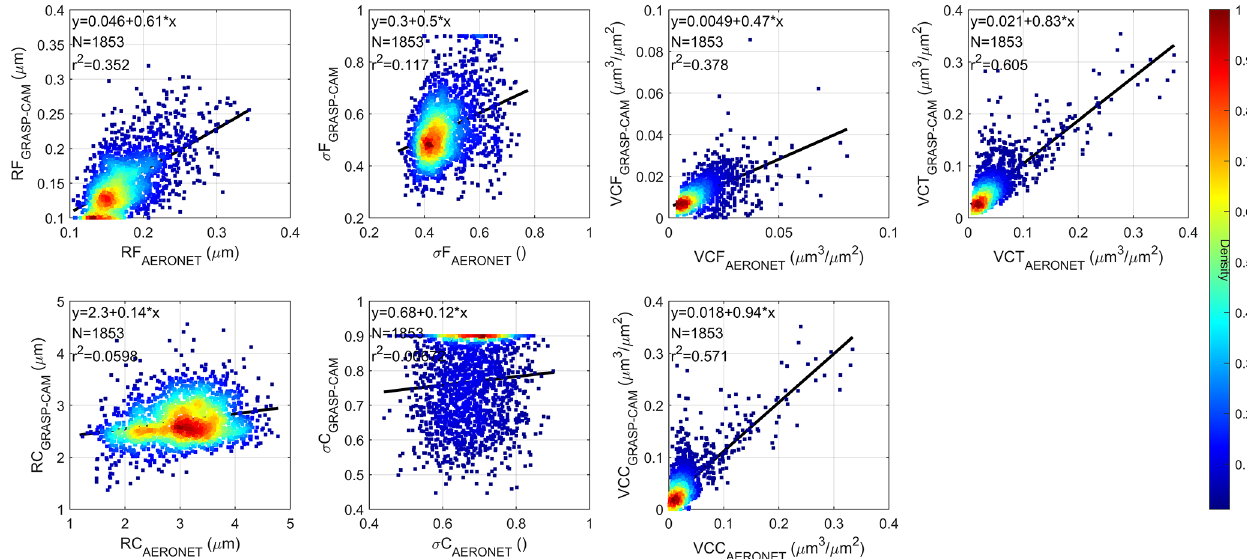
Figure 13. Density scatter plots of the aerosol size distribution properties retrieved by GRASP in single-pixel approach (GRASP-CAM) versus the ones retrieved by AERONET; linear fit (black line), its equation and the determination coefficient ( r 2 ) are also shown. These size distribution properties are volume median radius of fine (RF) and coarse (RC) modes, standard deviation of log-normal distribution for fine ( σ F) and coarse ( σ C) modes, and aerosol volume concentration for fine (VCF) and coarse (VCC) modes and the total value (VCT).